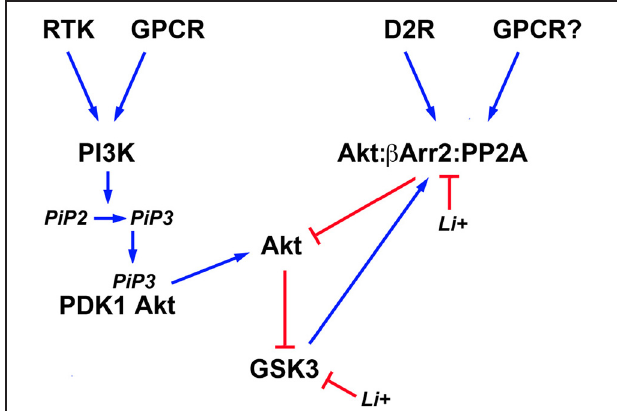
FIGURE 2 | Schematic representation of signaling pathways regulating the activity of brain GSK3 and its regulation by lithium. Activation of different cell surface receptors activates Phosphatidylinositol 3-kinases (PI3K) that in turn phosphorylates Phosphatidylinositol 4,5-bisphosphate (PIP2) into Phosphatidylinositol (3,4,5)-triphosphate (PIP3). Availability of PIP3 causes the co-recruitment of the 3-phosphoinositide dependent protein kinase-1 (PDK1) and Akt to the cell membrane and the activation of Akt by PDK1. Phosphorylation of N-terminal serine residues of glycogen synthase kinase 3 (GSK3) isoforms by activated Akt results in GSK3 inactivation. Conversely, activation of the D2 dopamine receptor (D2R) and potentially of other G protein coupled receptors (GPCR) triggers the formation of a signaling complex composed of Akt, beta-arrestin 2 ( β Arr2), and protein phosphatase 2A (PP2A) that results in an inactivation of Akt and concomitant relived GSK3 inhibition. Lithium can affect the equilibrium of this signaling network by inhibiting GSK3 directly and by disrupting the assembly of the Akt; β Arr2;PP2A signaling complex. In addition, activated GSK3 would contribute to its own regulation by Akt by stabilizing the formation of this same protein